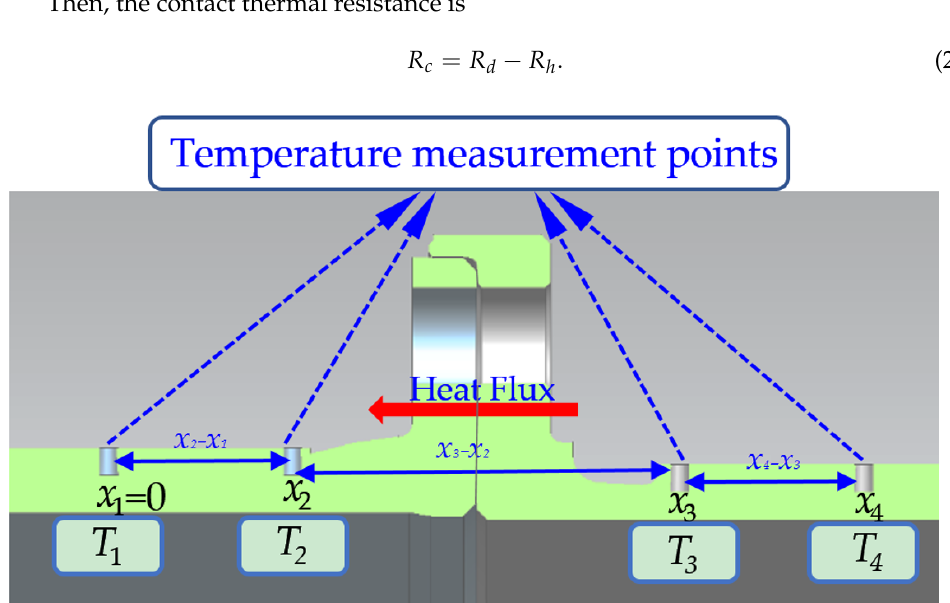
Figure 5. Distribution of temperature measurement points in the assembled experimental section.